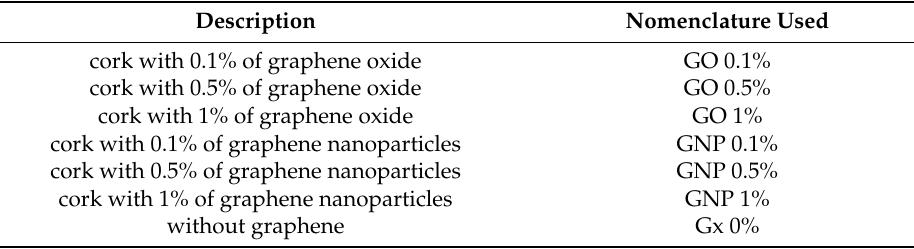
Table 1. Description and nomenclature used for the produced